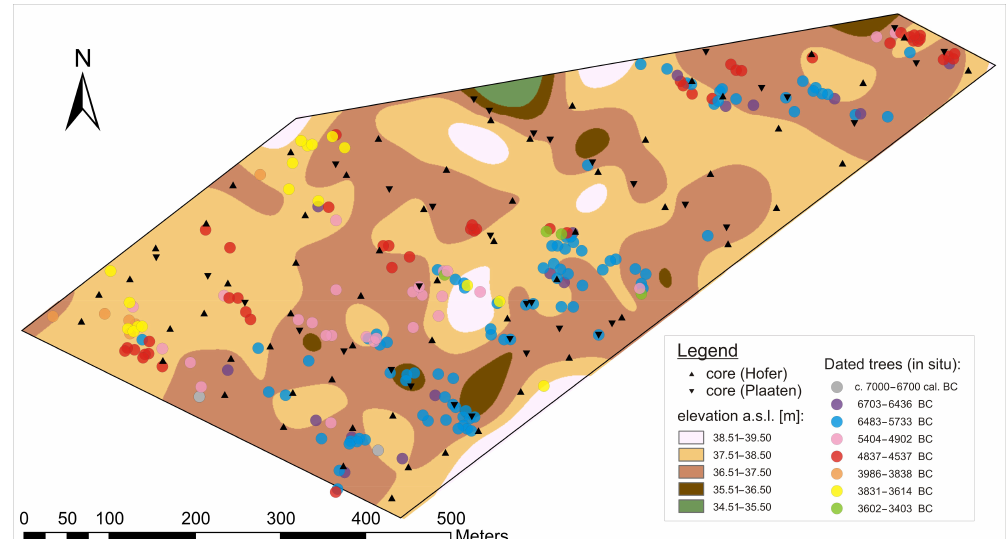
Figure 6. Elevations a.s.l. of the mineral base (sand) below the peat. Regularized spline interpolation of 99 measurements. The elevations are interpolated using a regularized spline. The actual measurements range from 36.42 to 38.16ma.s.l.; therefore, the first and the last elevation class (green, below 35.50ma.s.l., and white, above 38.51ma.s.l.) are products of extrapolation only. The coring points are indicated by triangles. The dated in situ trees are shown as circles, for each chronology segment (Table 1) in a different colour (C14: grey; A1: dark violet; A2: blue; B: pink; C: red; D: orange; E: yellow; F: